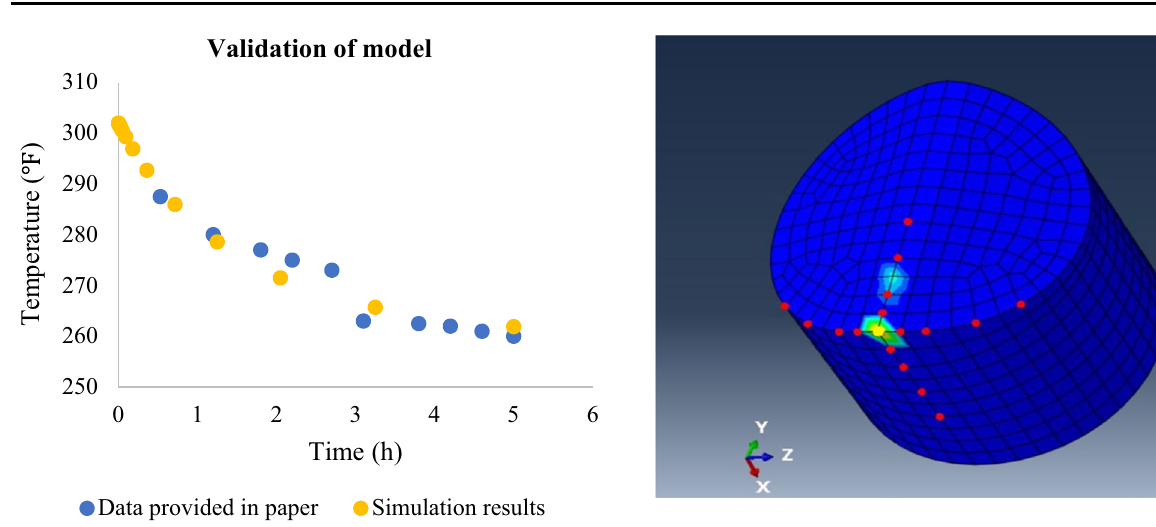
Fig. 9 Thermal behavior validation of the model